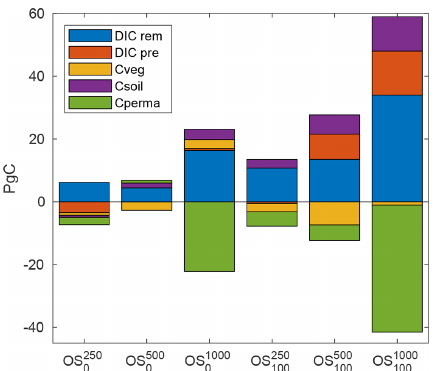
Figure 7. Changes in stock size for the main carbon reservoirs of the Earth system at the end of the overshoot simulations (indicated along the x axis) relative to the reference simulation without over-